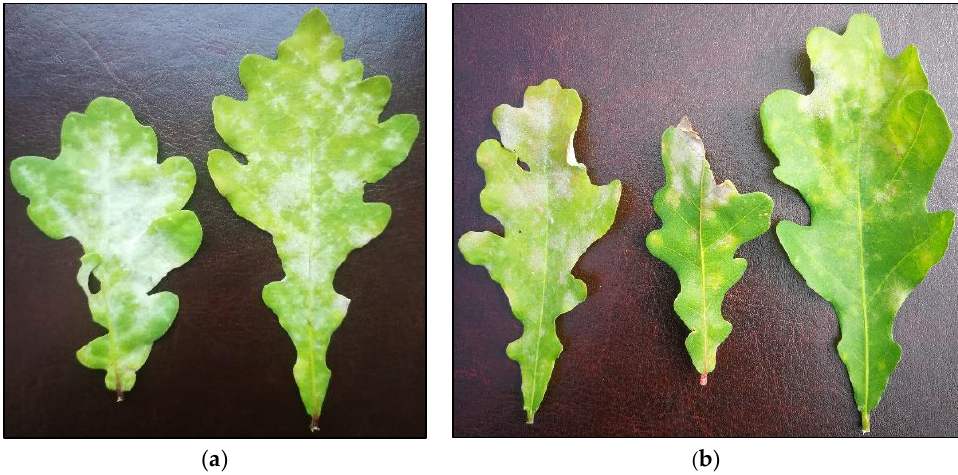
Figure 3. Powdery mildew mycelium scattered over a larger area after 69 days of fungal inoculation: ( a ) C+; ( b ) after five treatments with CHL. Table 1. The percentage of seedlings with visible symptoms of powdery mildew on the following days after inoculation.